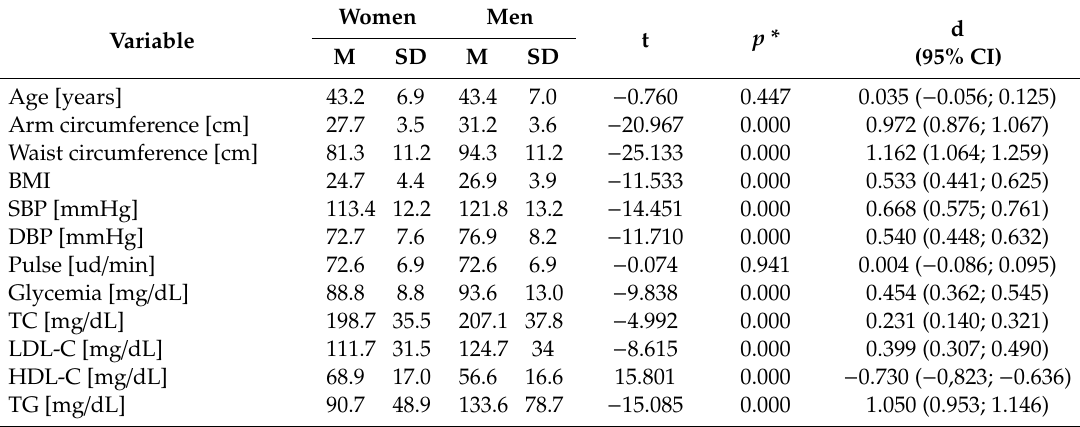
Table 3. Mean values of selected parameters with regard to sex.